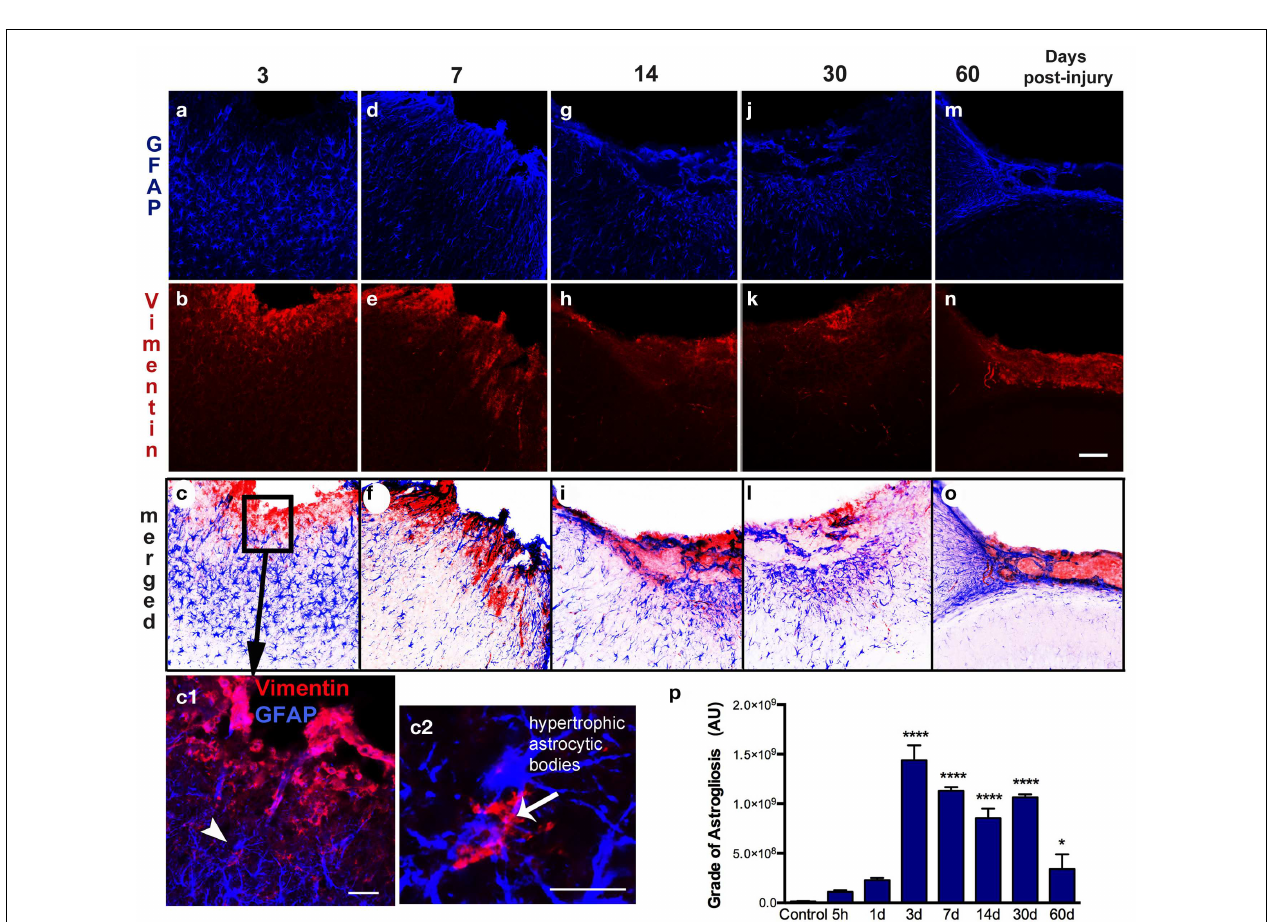
increased number of short, thick processes that are directed towards the border of the lesion at 7dpi (d–f). Extensive reactive astrogliosis was primarily detected in the border of the damaged cortex at 14dpi (g–i). Once the glial scar has formed, both GFAP and vimentin expression is weak and restricted to the superficial part of the injured cortex at 30 and 60dpi (m–o). Quantification of the grade of astrogliosis (p) showed a peak at 3dpi that decreases overtime. Scale bar; 100 µ m (a–o), 50 µ m (c1), and 20 µ m (c2). Values are expressed as mean ± SEM, n = 3–5 per group, **** p < 0.0001, * p < 0.05 compared to